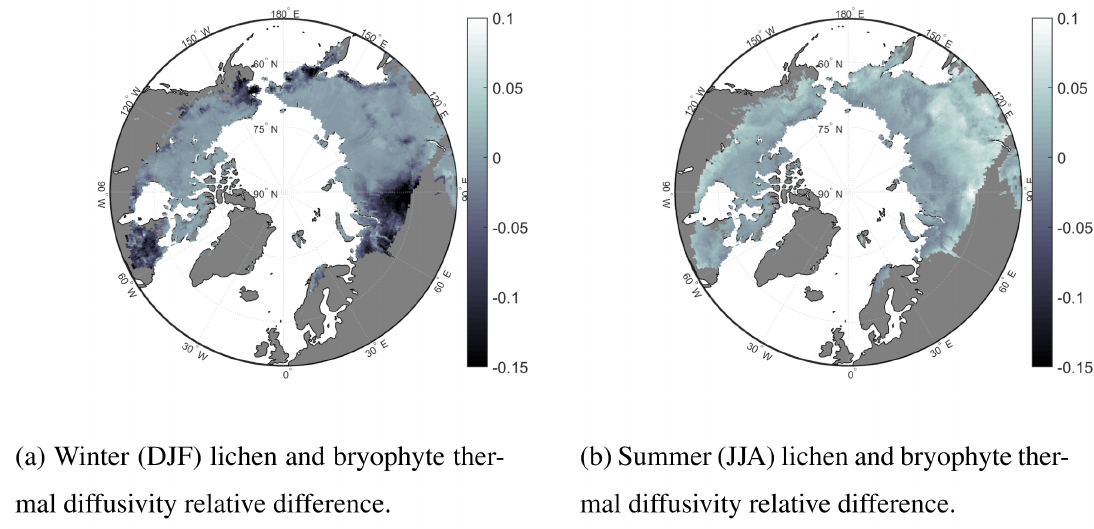
Figure 8. Comparison of lichen and bryophyte 1980–2009 average properties. Relative difference (REDVAR − CNTL)/CNTL expressed as a fraction